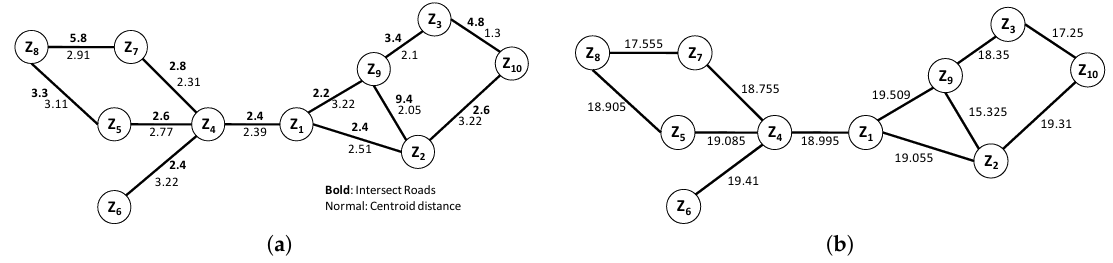
Figure 11. Proximity computation. ( a ) Zip code graph example. ( b ) ZIP code graph with adjacent